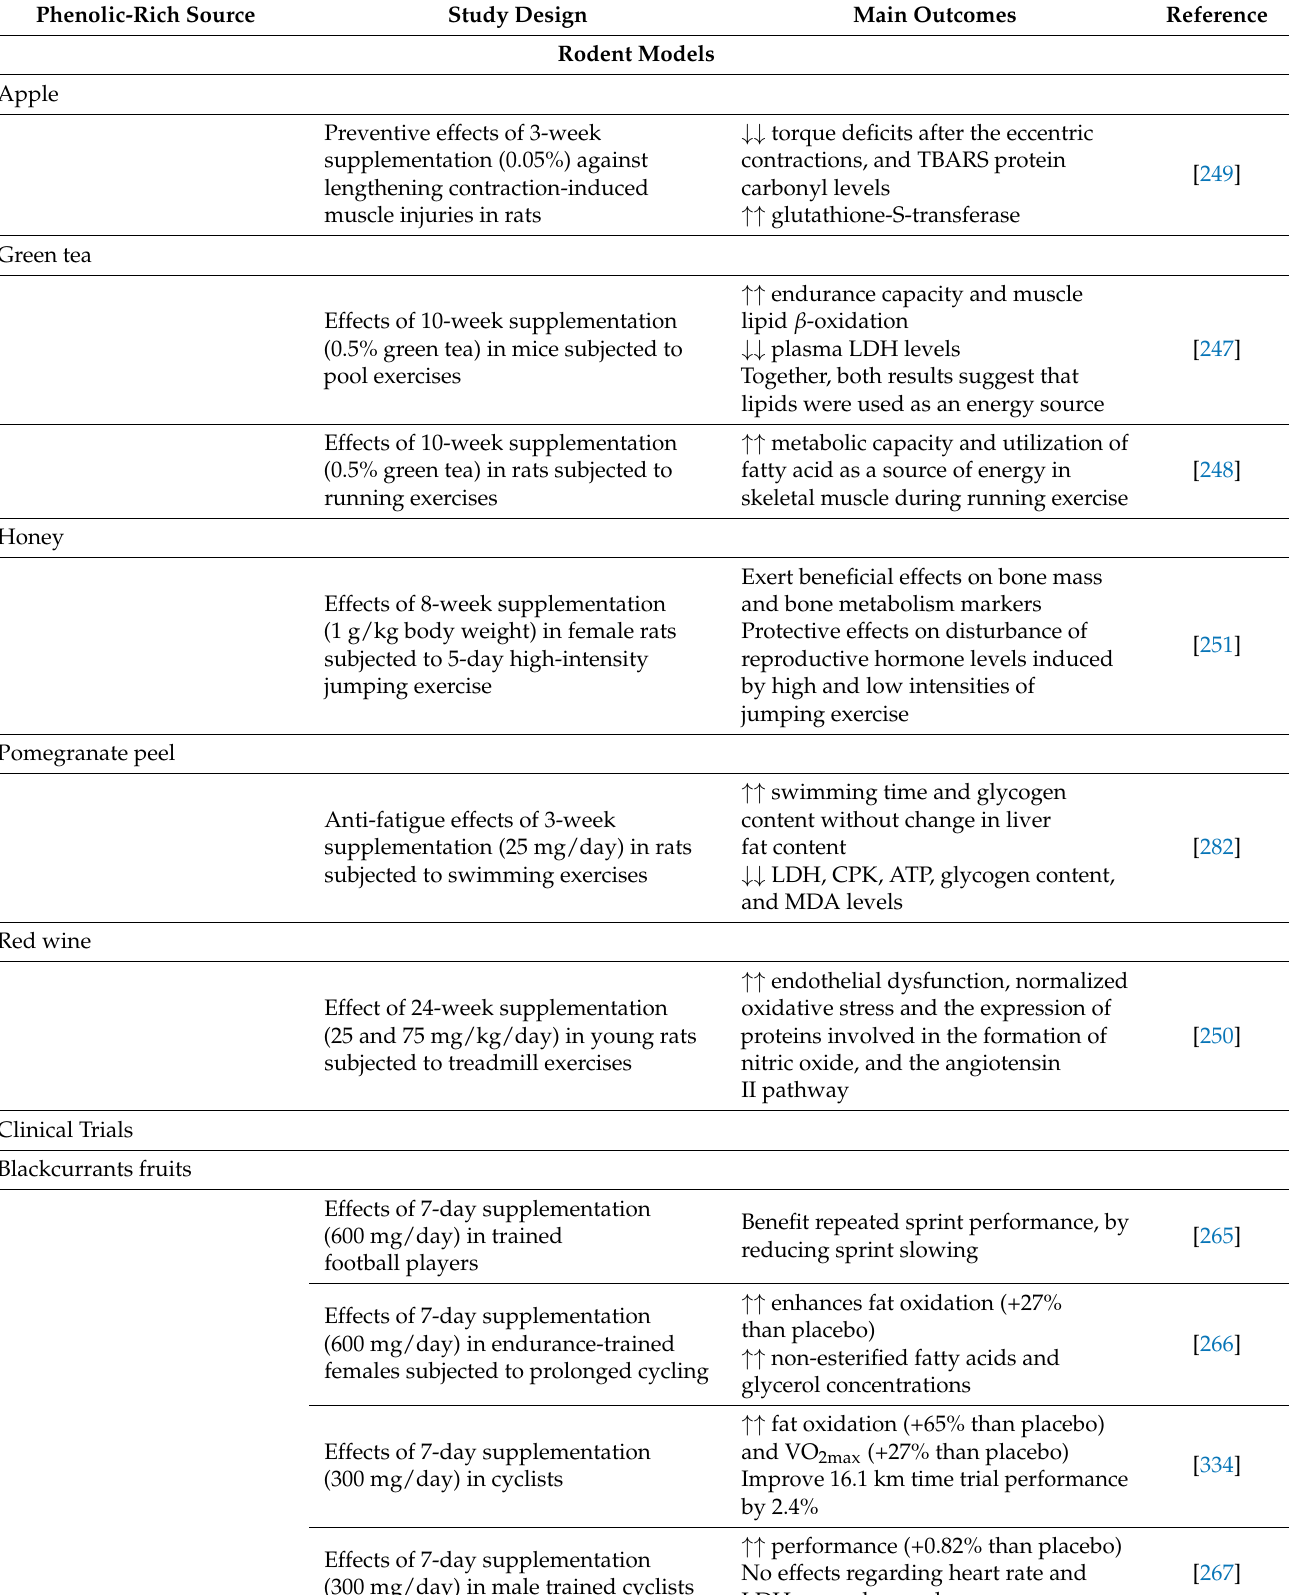
Table 2. Main effects of phenolic-rich sources in